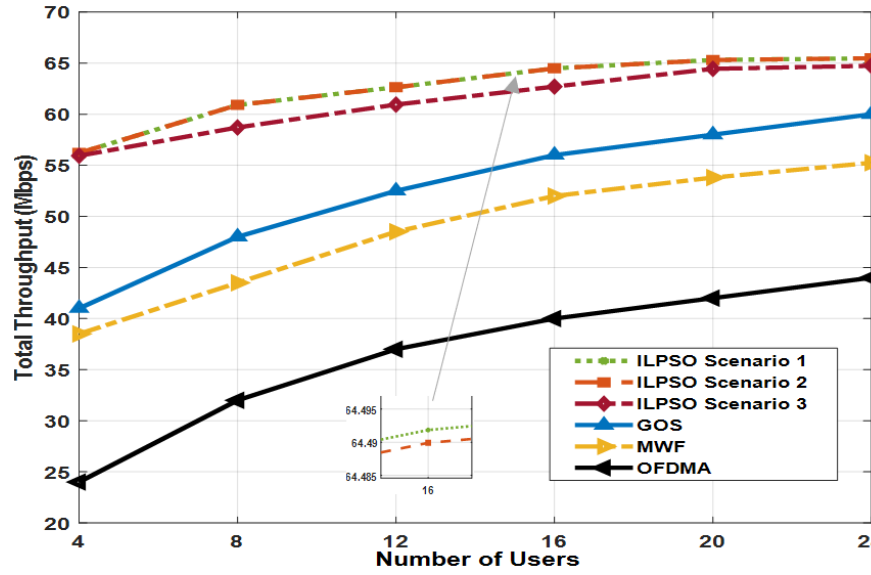
Figure 2. System throughput vs. the number of users.